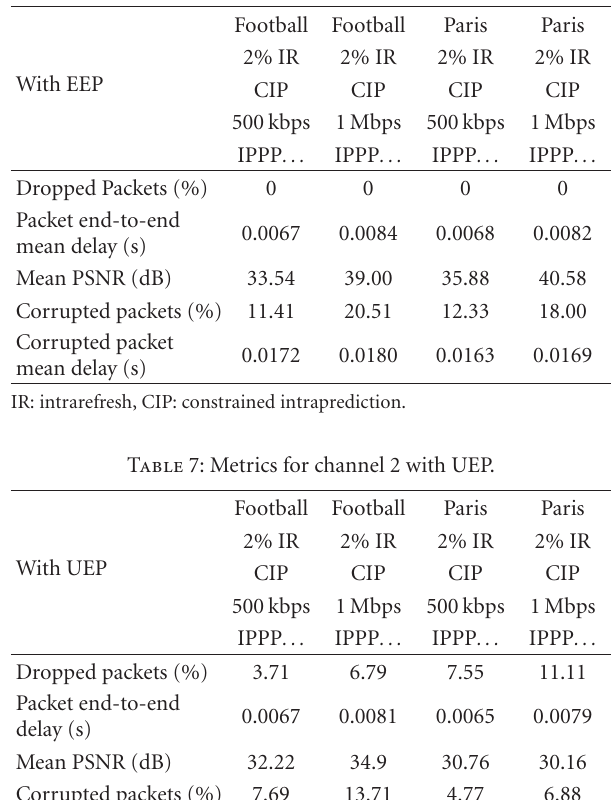
Table 6: Metrics for channel 2 with EEP.